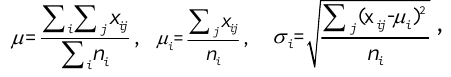
Algorithm 1: pattern selection Inputs: pattern set P , trace database TDB, coverage threshold 